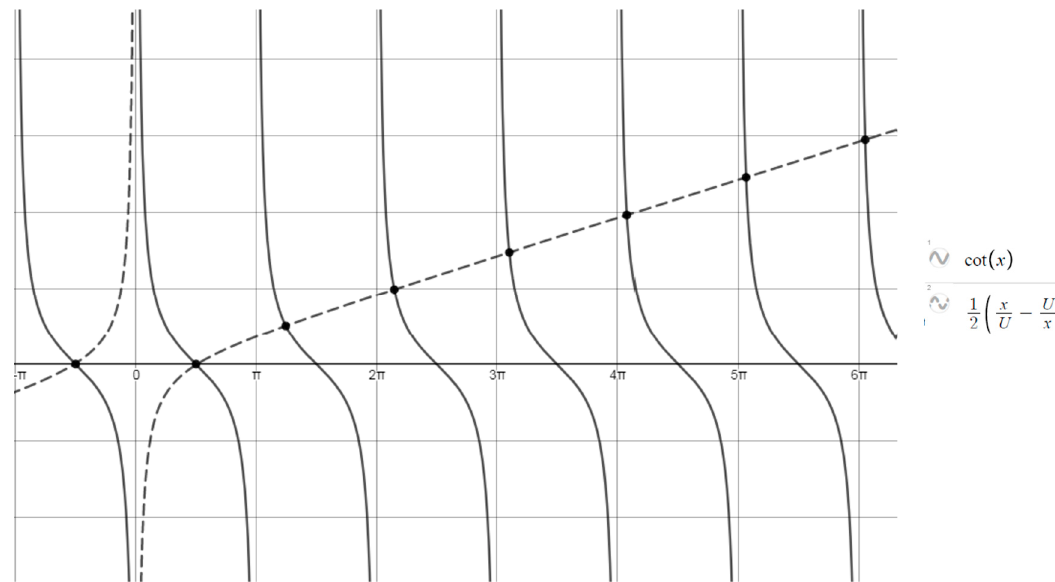
Figure 1. The solutions of Equation (20).